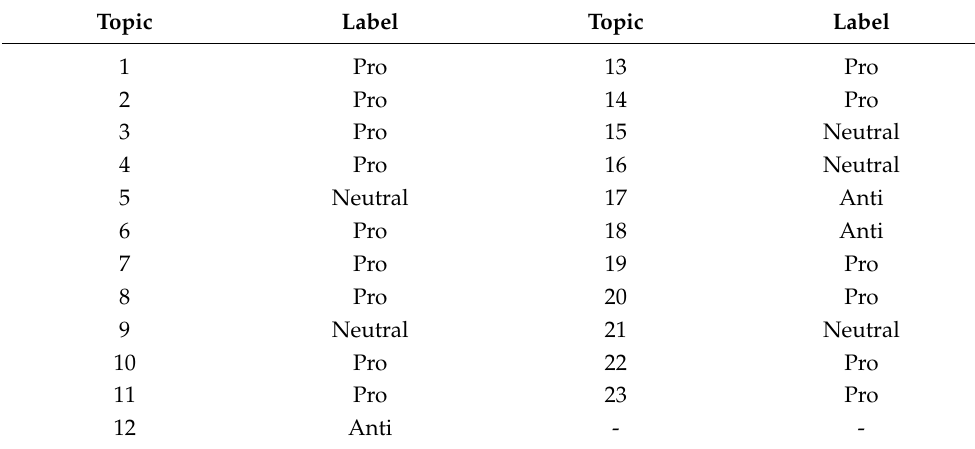
Table 1. Results of the manual annotation